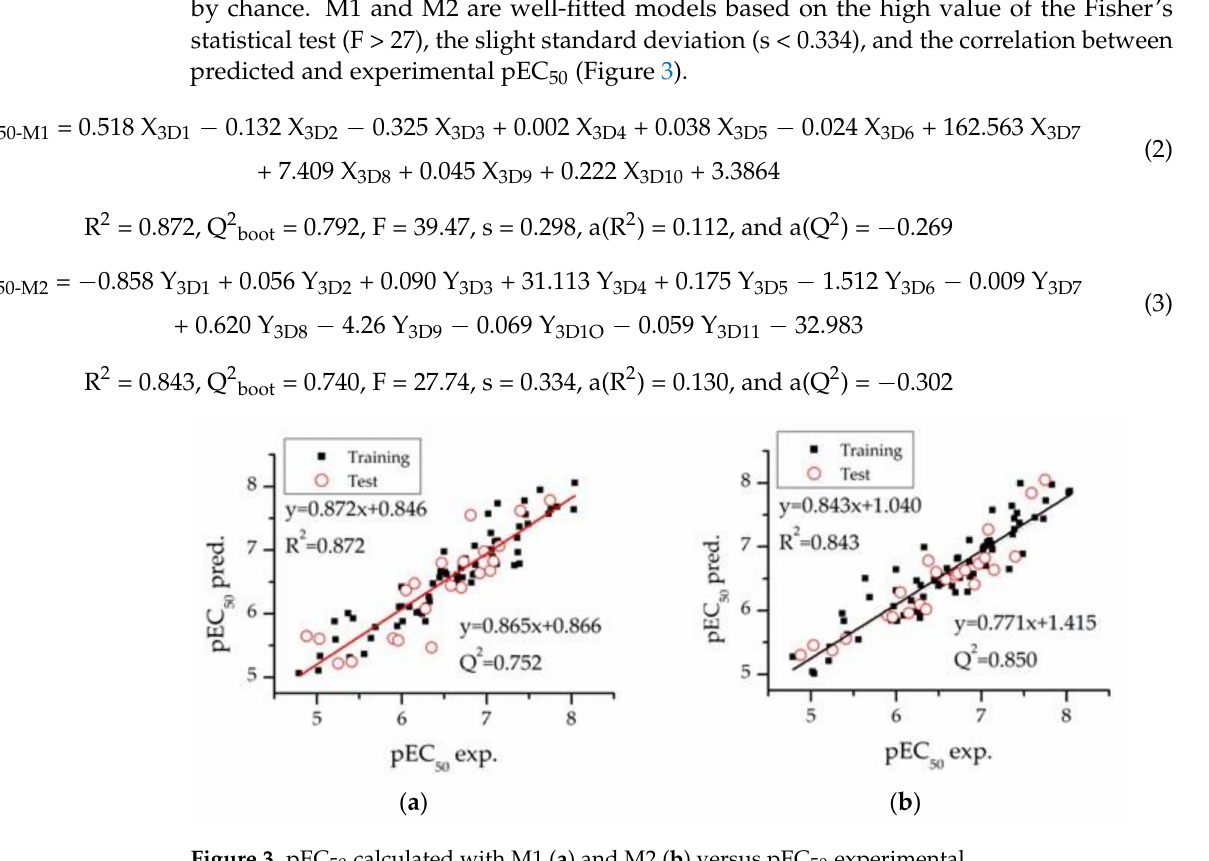
Figure 3. pEC 50 calculated with M1 ( a ) and M2 ( b ) versus pEC 50